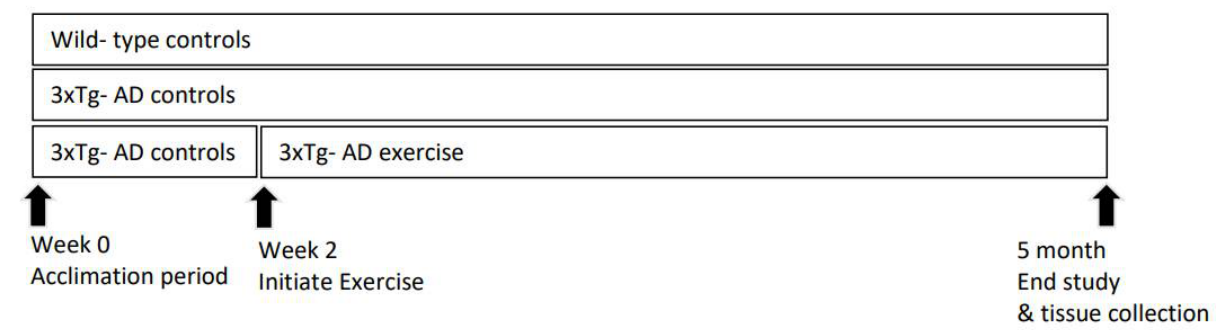
Figure 1. A schematic demonstrating the study